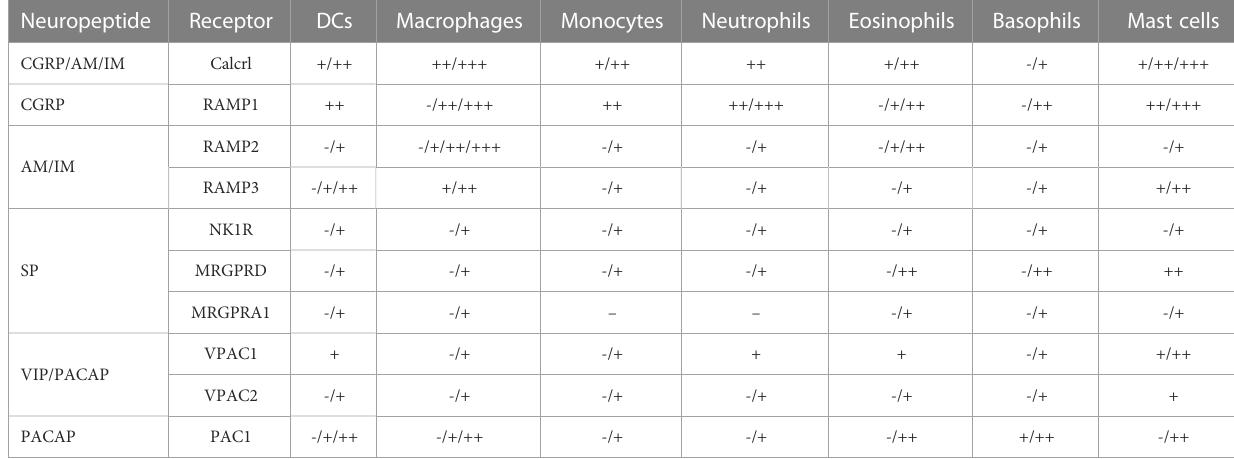
TABLE 2 Expression of neuropeptide receptors on immune cells based on the RNAseq and microarray data deposited in the Immgen database (42)